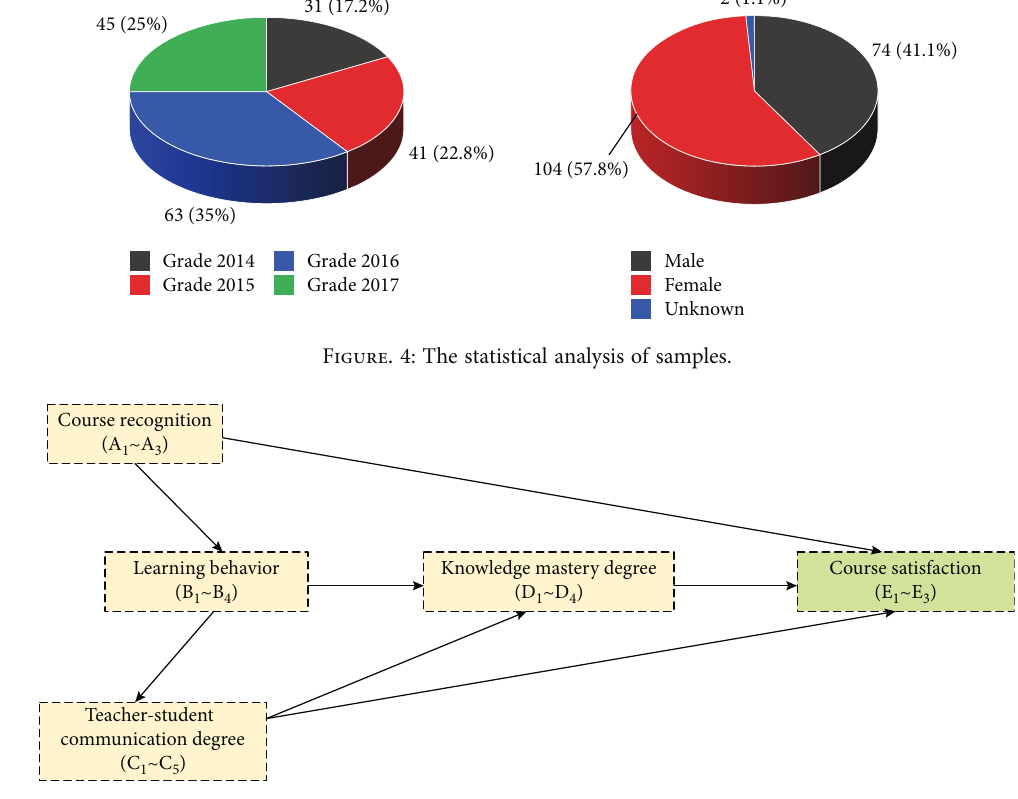
Figure. 5: Schematic diagram of the teaching model of health